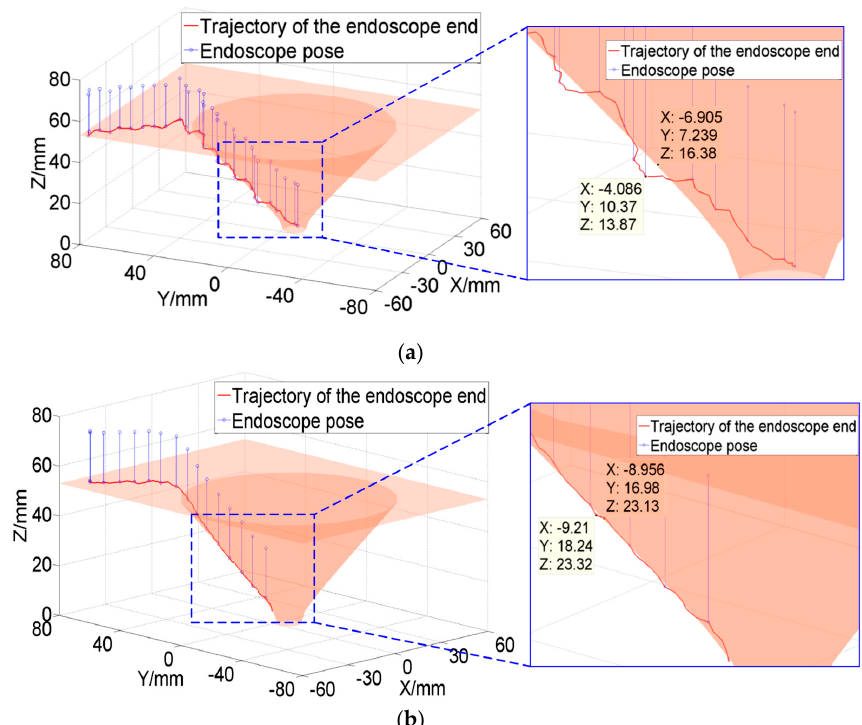
Figure 13. Comparison of the experimental results of the composite FRVF. ( a ) Endoscopic tip trajectory without FRVF constraint; ( b ) endoscopic tip trajectory with the composite FRVF constraint.